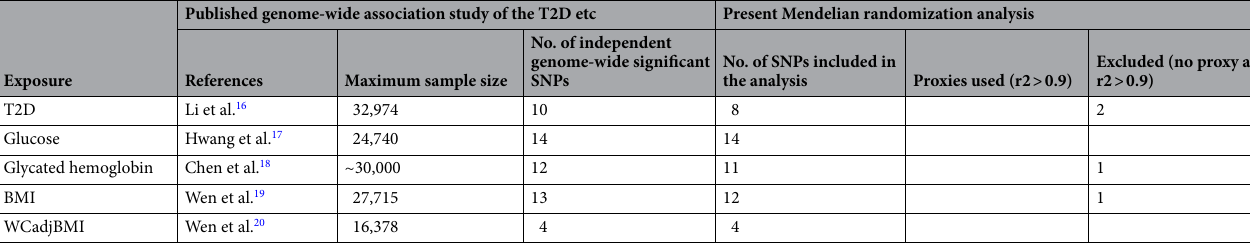
Table 2. Characteristics of instrumental variables used in the Mendelian randomization analyses in East Asian ancestry. SNPs single nucleotide polymorphisms, T2D type 2 diabetes, BMI body mass index.